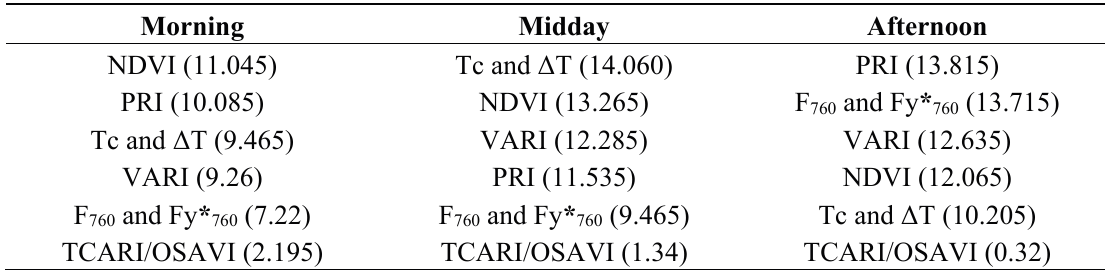
Table 5. Ranking of different indices derived from both the AHS and CASI indices for the three overpasses based on the non-parametric Kruskal–Wallis test. The value of the Kruskal–Wallis statistic is reported within